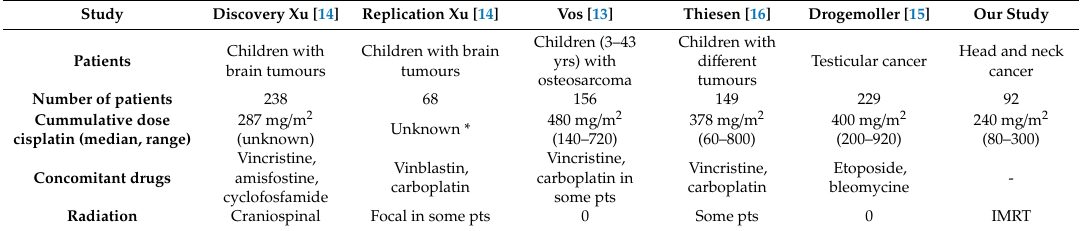
Table 5. Overview of performed studies to ototoxicity and